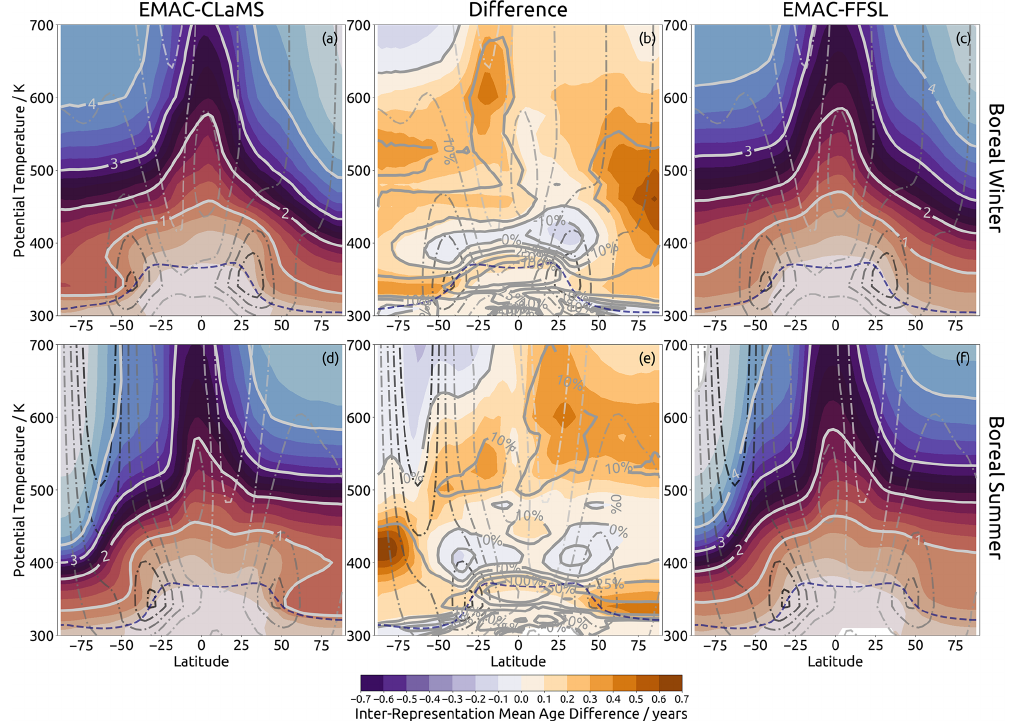
Figure 1. Mean age of air computed from age spectra for EMAC-CLaMS (a, d) and EMAC-FFSL (c, f) and the difference between them (b, e) in boreal winter (mean of December, January, and February) (a, b, c) and boreal summer (mean of June, July, and August) (d, e, f) . For the central figures, shading shows the absolute differences (in years) between the representations (EMAC-CLaMS minus EMAC-FFSL) and contours show percentage differences (with EMAC-FFSL as baseline). Otherwise, contours and shading show mean age (in years), with a shading interval of 0.25